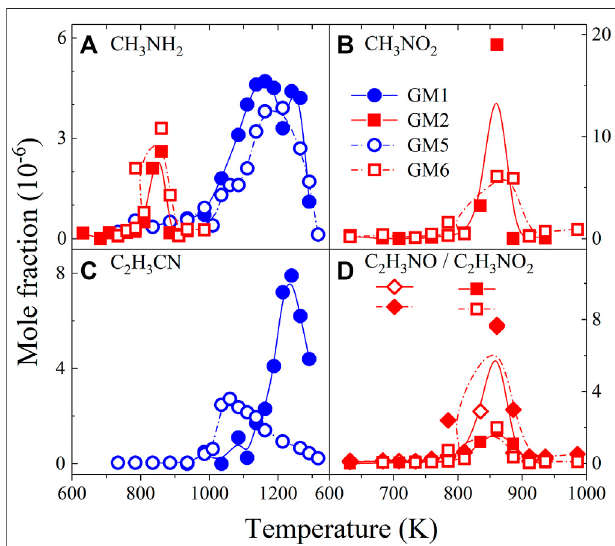
FIGURE 11 | Experimental mole fraction pro fi les of methylamine (CH 3 NH 2 ), nitromethane (CH 3 NO 2 ), vinyl cyanide (C 2 H 3 CN)nitrosoethylene (C 2 H 3 NO) and nitroethylene (C 2 H 3 NO 2 ) in the oxidation of GM1, GM2, GM5 and